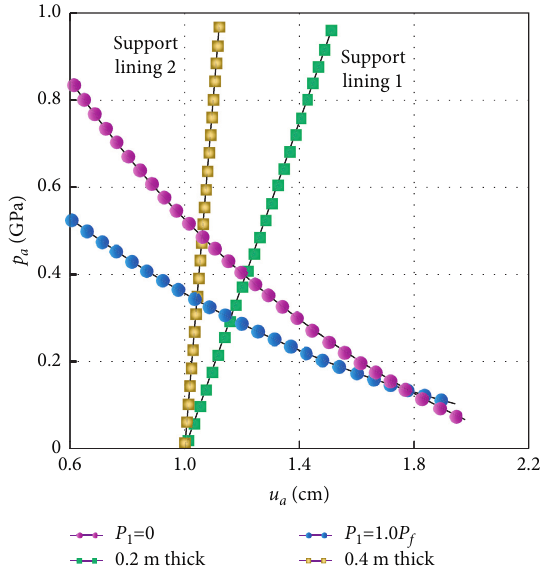
Figure 6: Comparison of surrounding rock characteristics before and after roadway support.